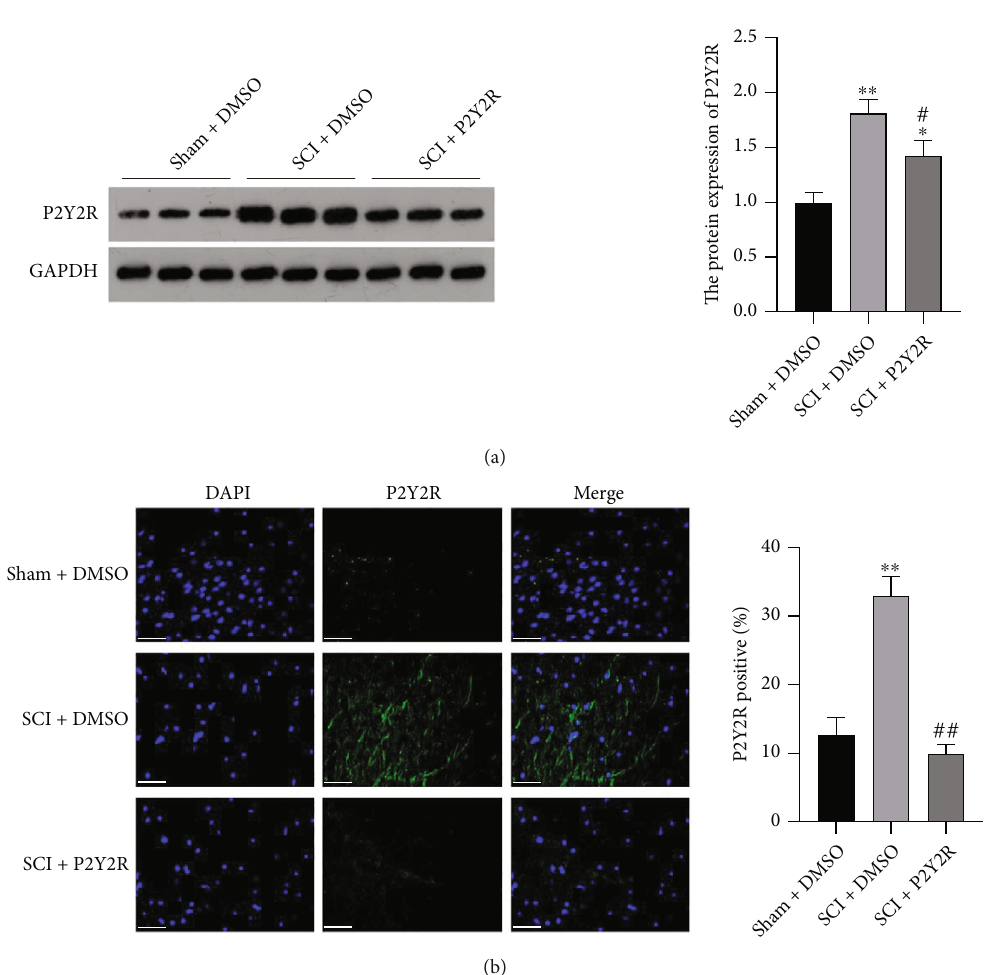
Figure 1: (a) The expression level of P2Y2R in spinal cord tissue detected by western blot. (b) The expression level of P2Y2R in spinal cord tissue detected by immuno fl uorescence staining. Scale bar = 50 μ m. ∗ p < 0 : 05 and ∗∗ p < 0 : 01 compared with the sham+DMSO group; # p < 0 : 05 and ## p < 0 : 01 compared with the SCI+DMSO